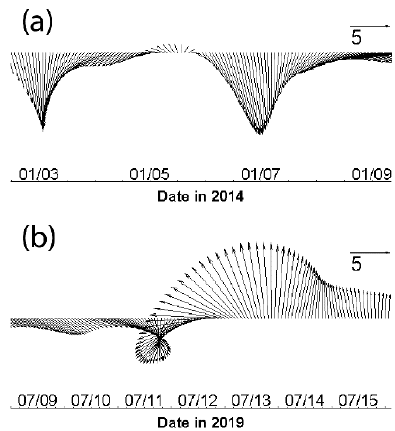
Figure 4. Wind vectors during cold front event in January 2014 and Hurricane Barry in July 2019. ( a , b ) show the wind vectors during cold front and hurricane, (max wind magnitude: 13.5 m/s and 14.5 m/s).